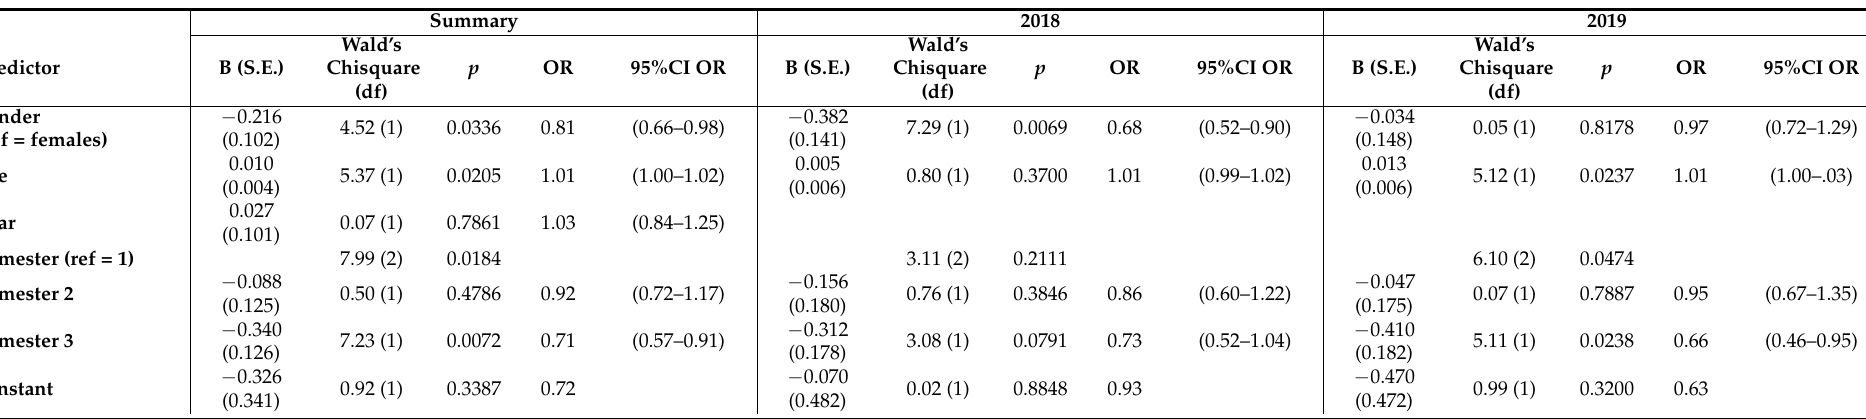
(summary), (ii) 2018 data, and (iii) 2019